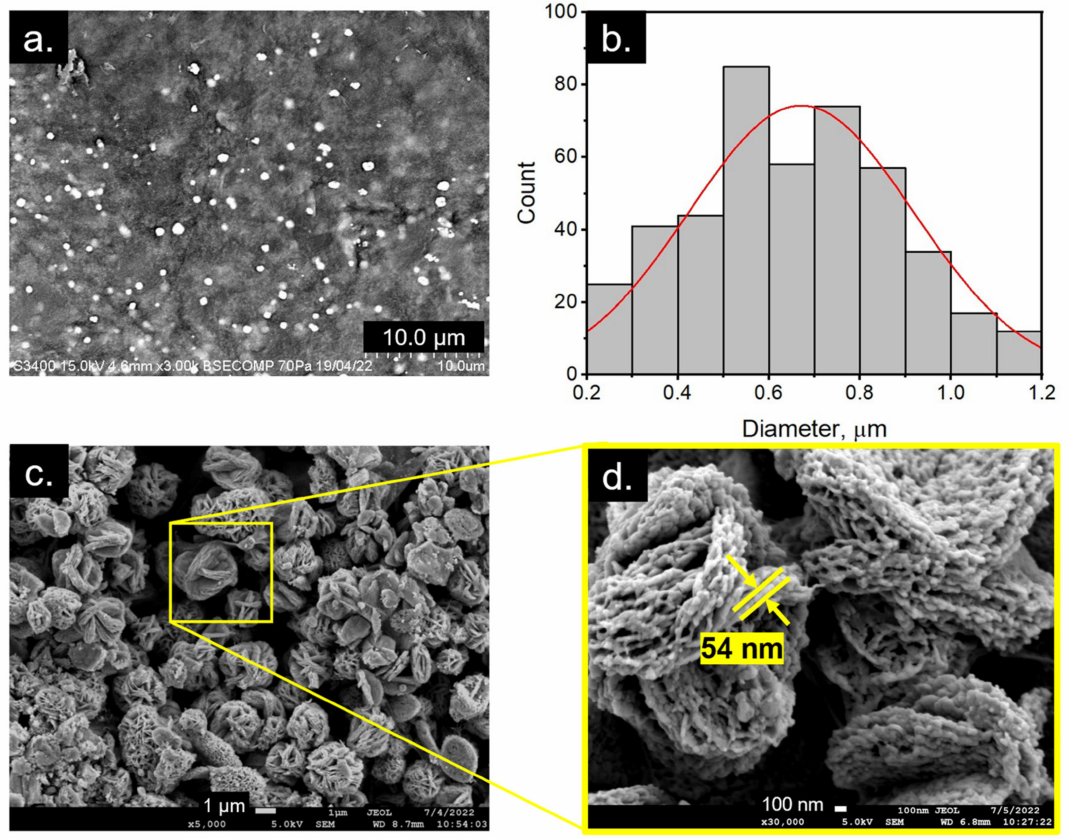
Figure 5. Morphological analysis of the AgNPs: ( a , b ) SEM image and the corresponding particle size distribution; ( c , d ) FE-SEM images at different